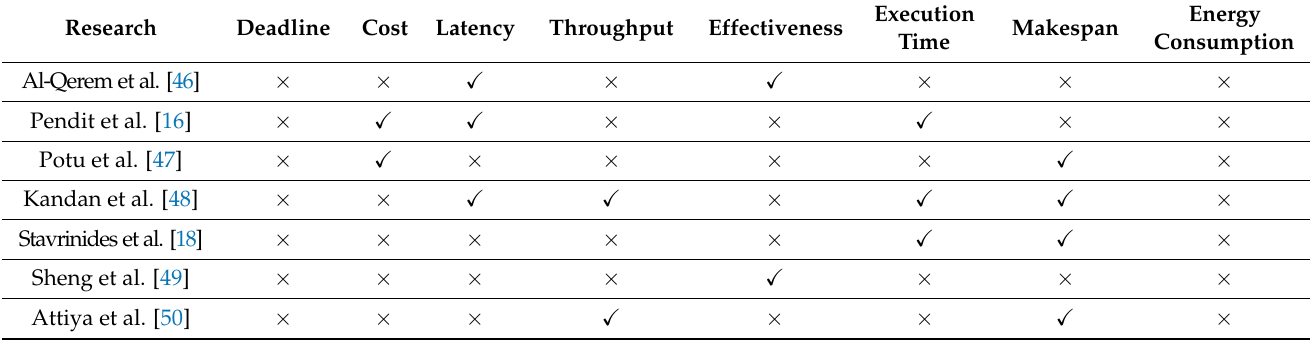
Table 21. Analysis of articles in terms of evaluation parameters in other application